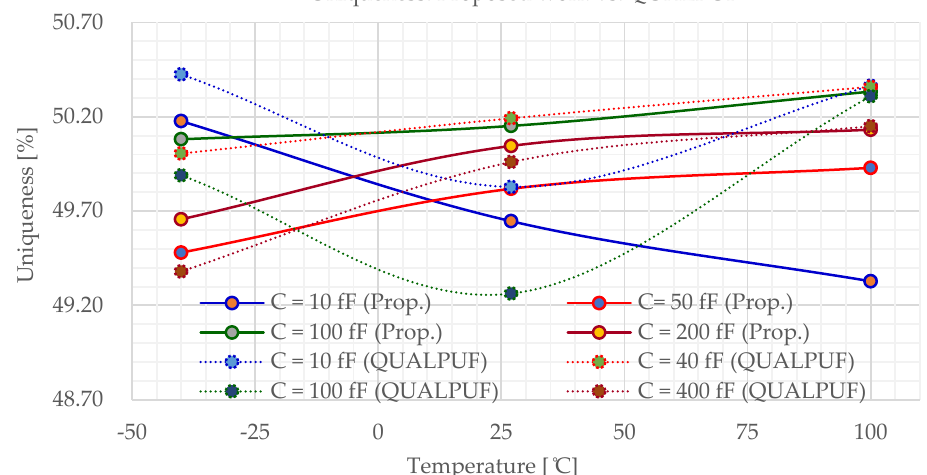
Figure 12. Uniqueness of the proposed adiabatic PUF (labeled as Prop.) versus QUALPUF under the V TH variation (4-bit PUF).